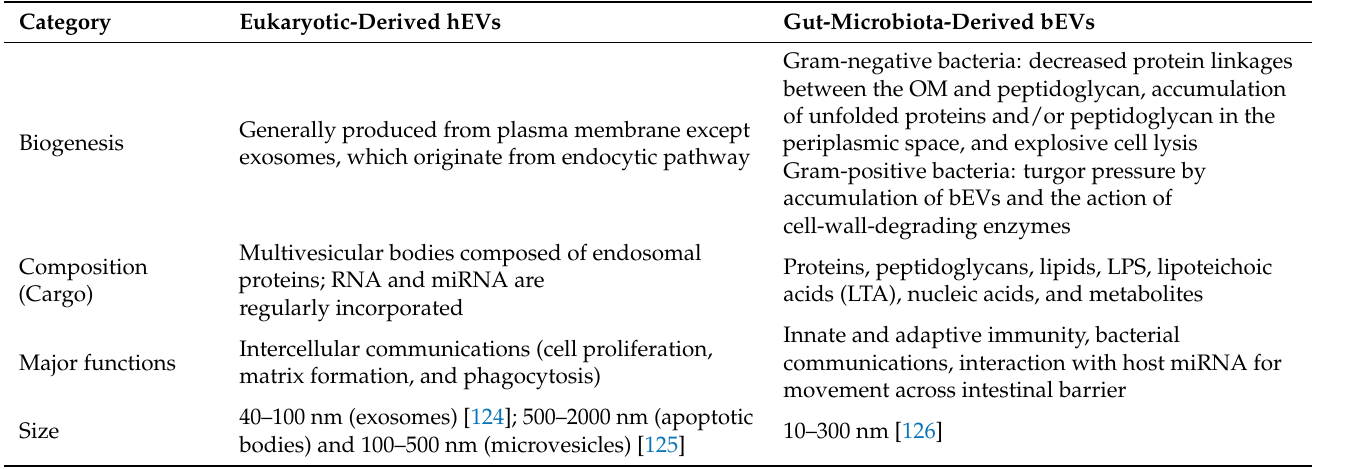
Table 3. Difference between eukaryotic-derived hEVs and gut-microbiota-derived